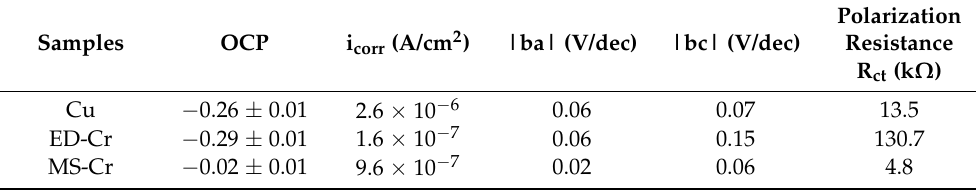
Figure 7. Schemes of the equivalent circuits used for modelling the EIS data in Figure 5. Scheme ( a ) was used for Cr-coated and ( b ) for copper substrate.